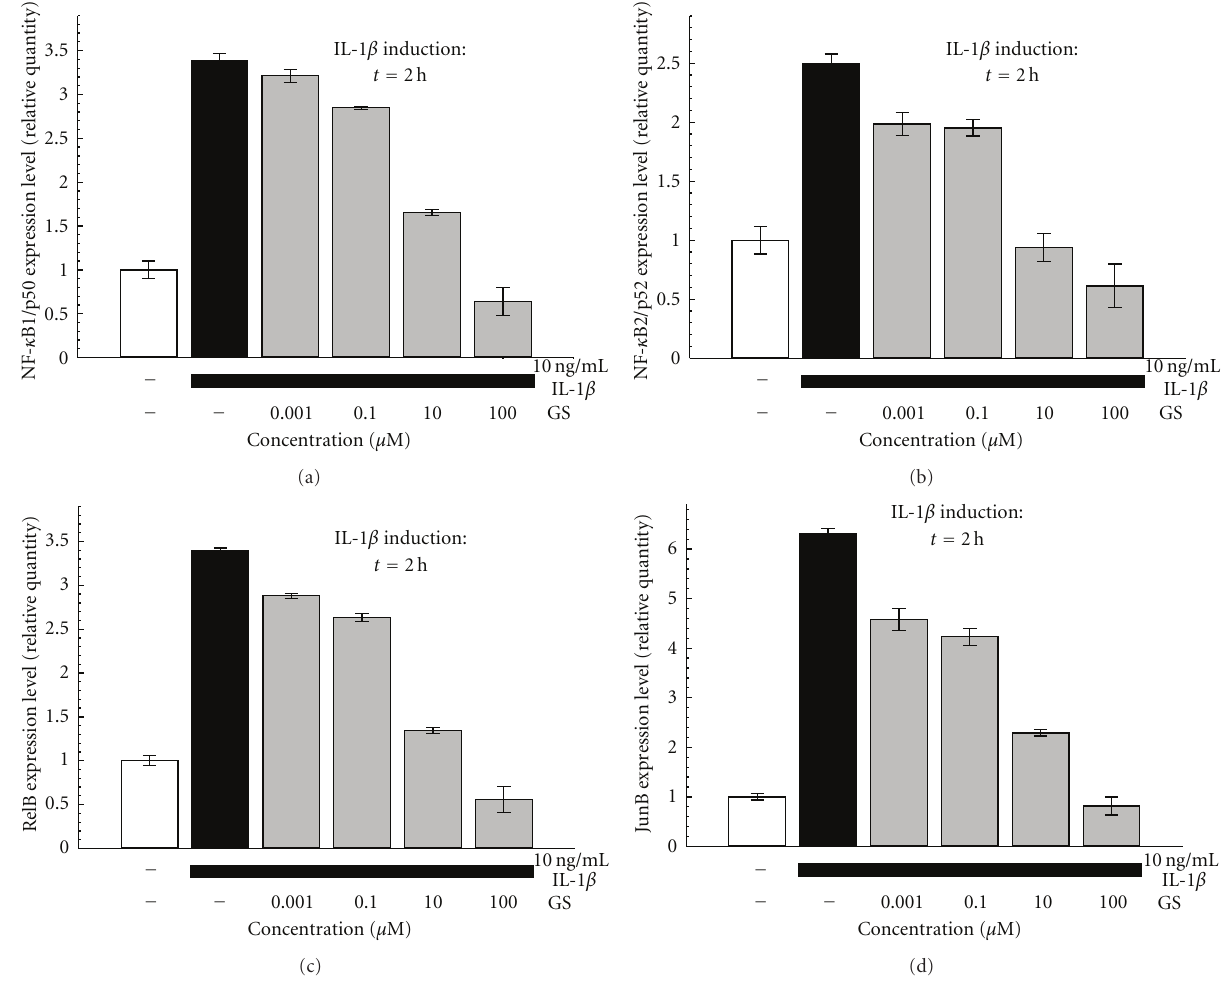
Figure 3: E ff ect of GS on IL-1 β -induced gene expression of NF- κ B1/p50 (a), NF- κ B2/p52 (b), RelB (c), and JunB (d). One hour after the pre-treatment with GS (0,001–100 μ M), SW1353 are stimulated with IL-1 β (10ng/mL) for 2h. Representative pictures of 3 to 5 independent experiments are shown. Data are mean ± SD of three